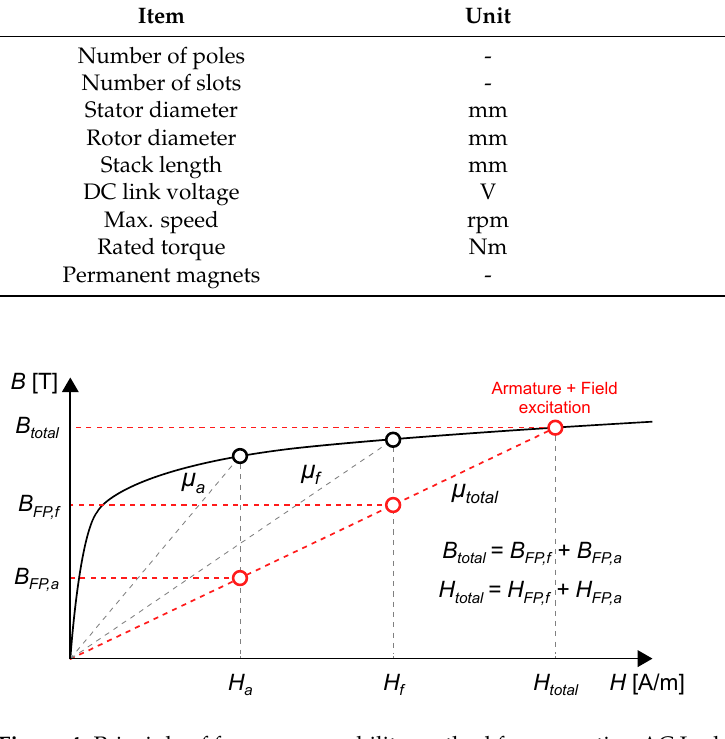
Figure 4. Principle of frozen permeability method for separating AC Joule